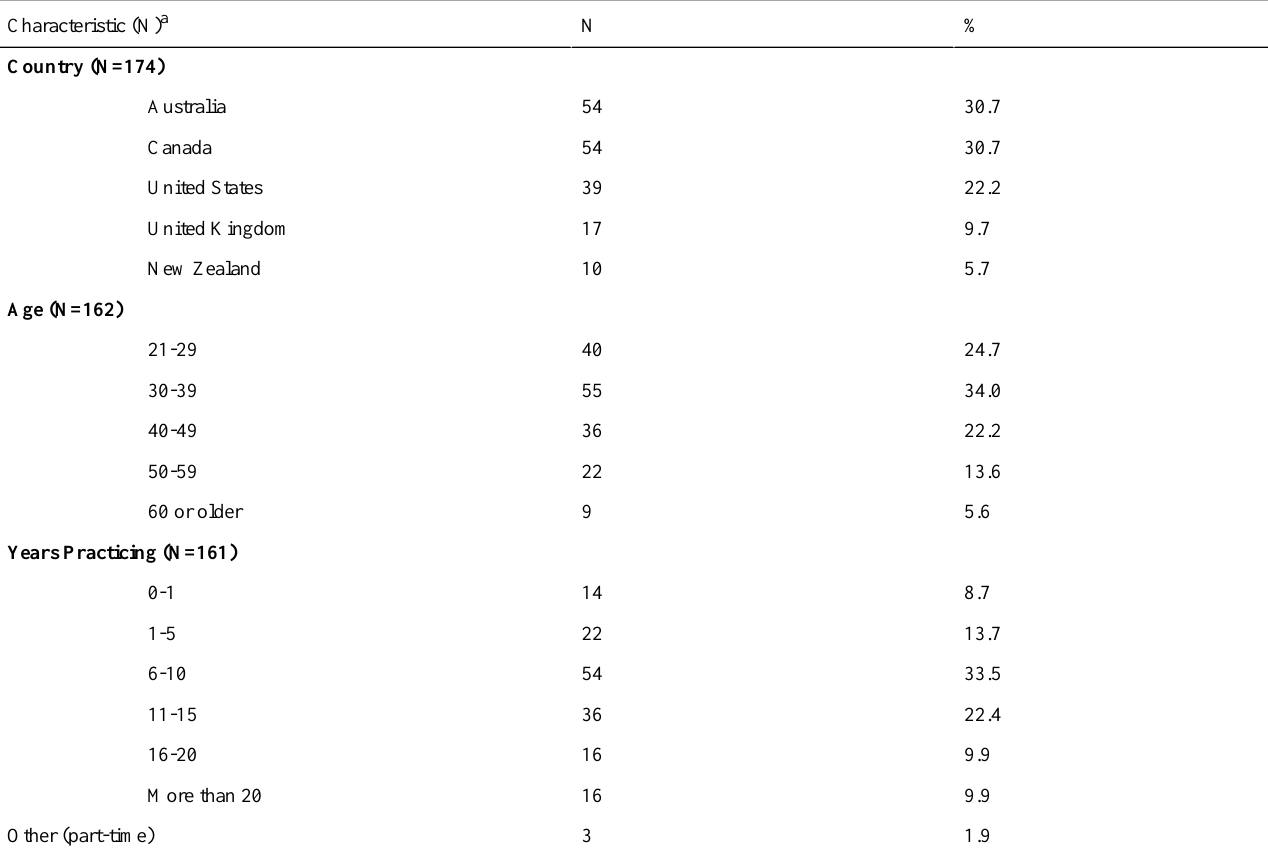
Table 1. Demographics of survey